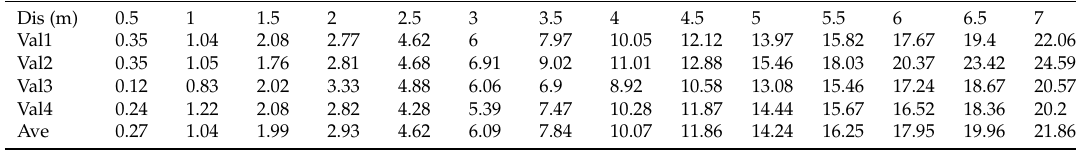
Table 5. Precision while using multi-scale 3D